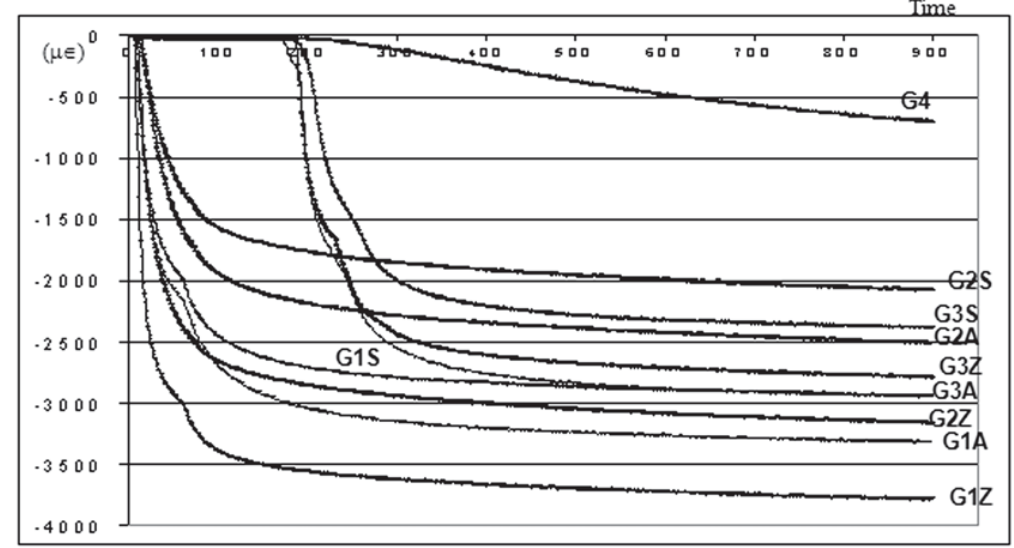
FIGURE 5- Shrinkage strain resulting from polymerization contraction of the experimental